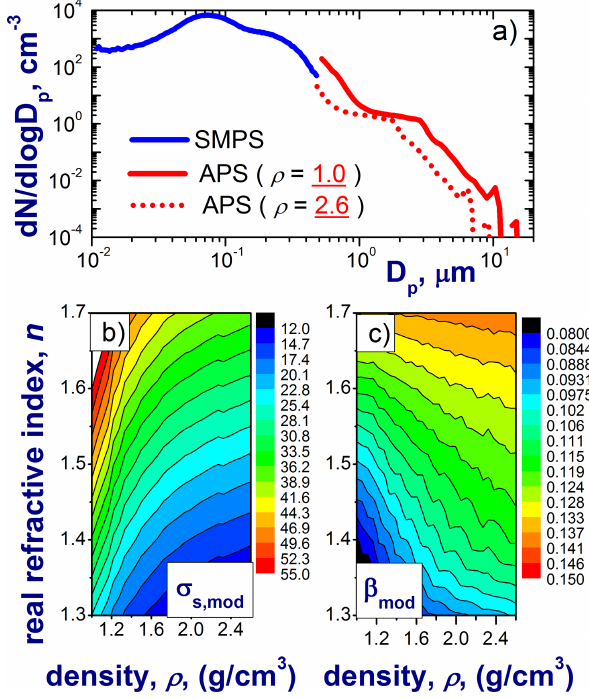
Figure 1. (a) Schematic illustration of merging the SMPS (diameter range 0.01 to 0.48µm) and APS (diameter range 0.52 to 19.8µm) distributions. (b, c) Example of 2-D diagrams of modeled particle light-scattering coefficient ( σ s , mod ) (b) and hemispheric backscatter fraction ( β mod ) (c) as a function of the real refractive index ( n) and effective density ( ρ) . The combined SMPS–APS distributions for a given ρ are used to obtain modeled optical properties as a function of n